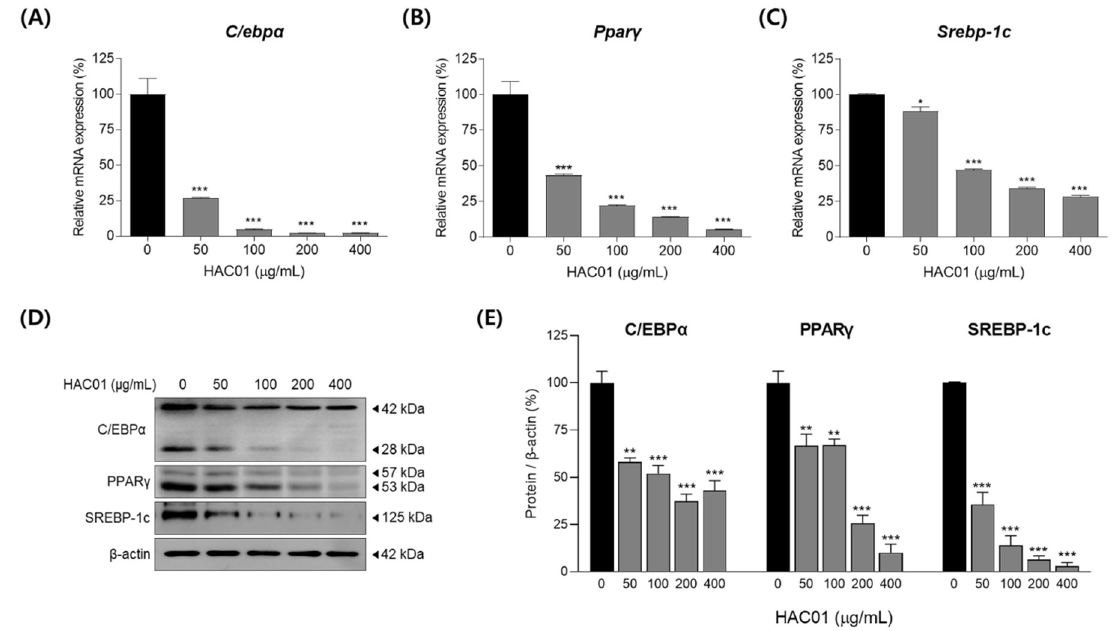
Figure 5. Effects of Lactobacillus plantarum HAC01 lysate on the expression of transcription factors during the early stage (2 d) of adipocyte differentiation in 3T3-L1 cells. Adipocyte differentiation was induced in the presence of L. plantarum HAC01 lysate for 2 d. mRNA expression levels of ( A ) C/ebpα , ( B ) Pparγ , and ( C ) Srebp-1c were quantified using qRT-PCR. ( D ) Western blot band images of transcription factors. Representative bands from triplicate experiments are shown. ( E ) Protein expression levels of C/EBPα (42 and 28 kDa), PPARγ (53 and 57 kDa), and SREBP-1c quantified using Western blotting. C/EBPα, CCAAT/enhancer-binding protein alpha; PPARγ, peroxisome proliferator-activated receptor-gamma; SREBP-1c, sterol regulatory element-binding protein 1c. All results are presented as mean ± SD. * p < 0.01, ** p < 0.005, and *** p < 0.001 vs. 0 μg/mL.